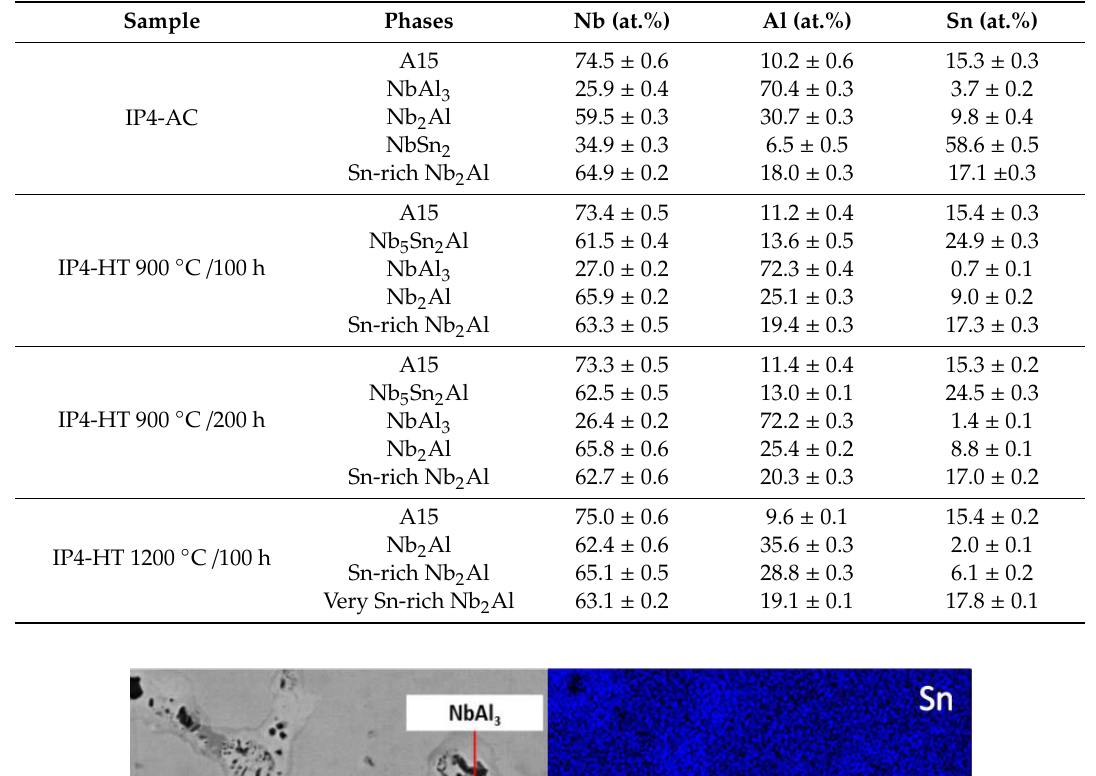
Table 2. EDS analysis of the phases in IP4-AC, IP4-HT 900 ◦ C / 100 h, IP4-HT 900 ◦ C / 200 h and IP4-HT 1200 ◦ C / 100 h alloys.